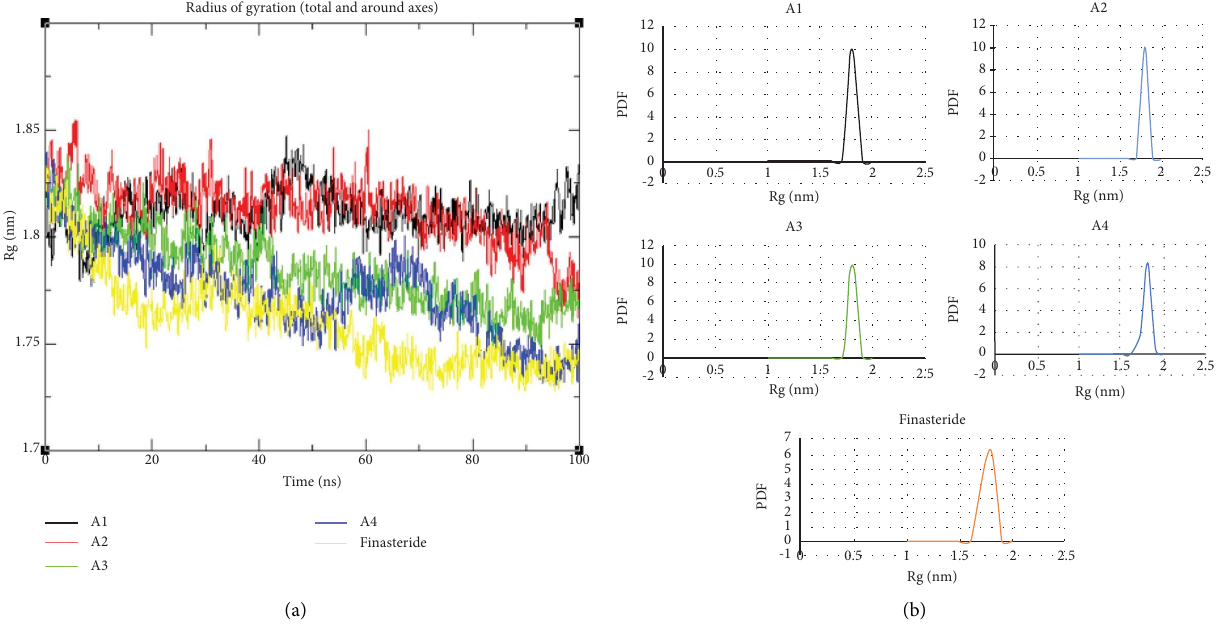
Figure 7: Te Rg analysis of 100ns molecular dynamics simulations of the hit complexes and fnasteride: (a) Rg plot for the four selected complexes; (b) PDF of Rg for the selected lead compounds.